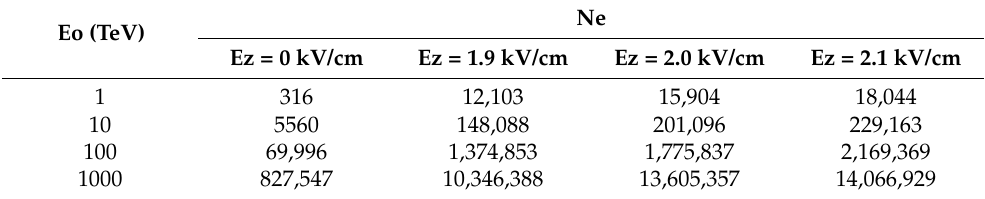
Table 2. Enhancement of the number of electrons initiated by a primary gamma ray with energies from 1 to 1000 TeV after passing the electric field of different strengths.